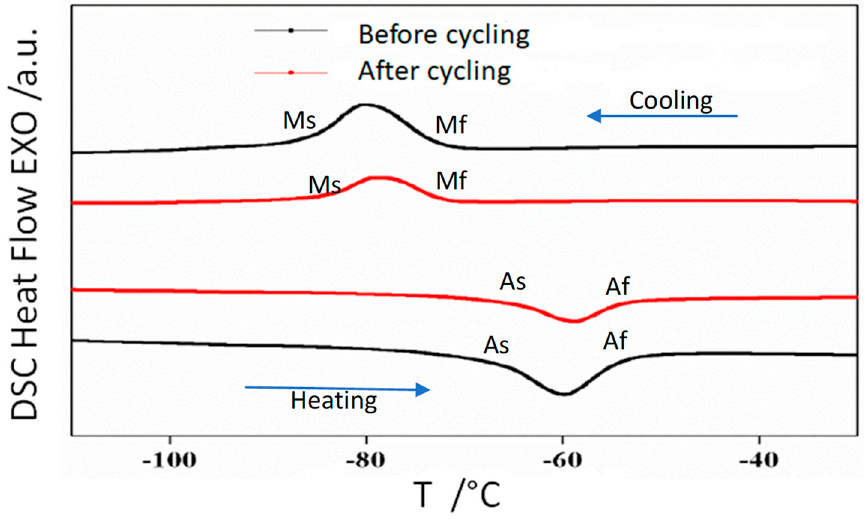
Figure 3. DSC reversible scans of alloy Ni 49 Mn 36 Sn 14 Cu 1 before and after 100 thermal cycles.